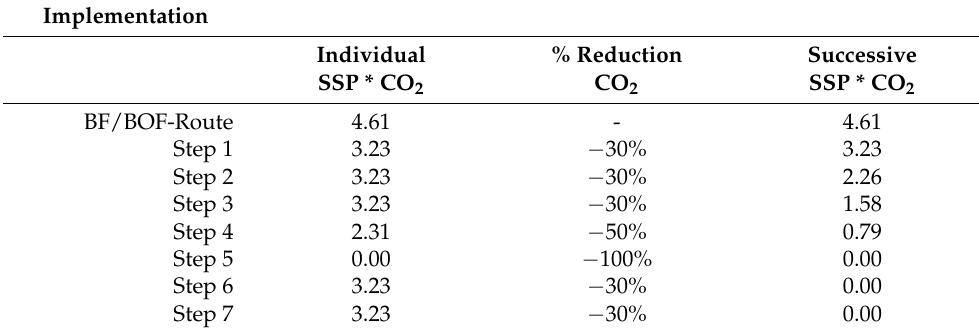
Table 2. Individual/successive implementation of the seven steps to 0-carbon steel. Implementation